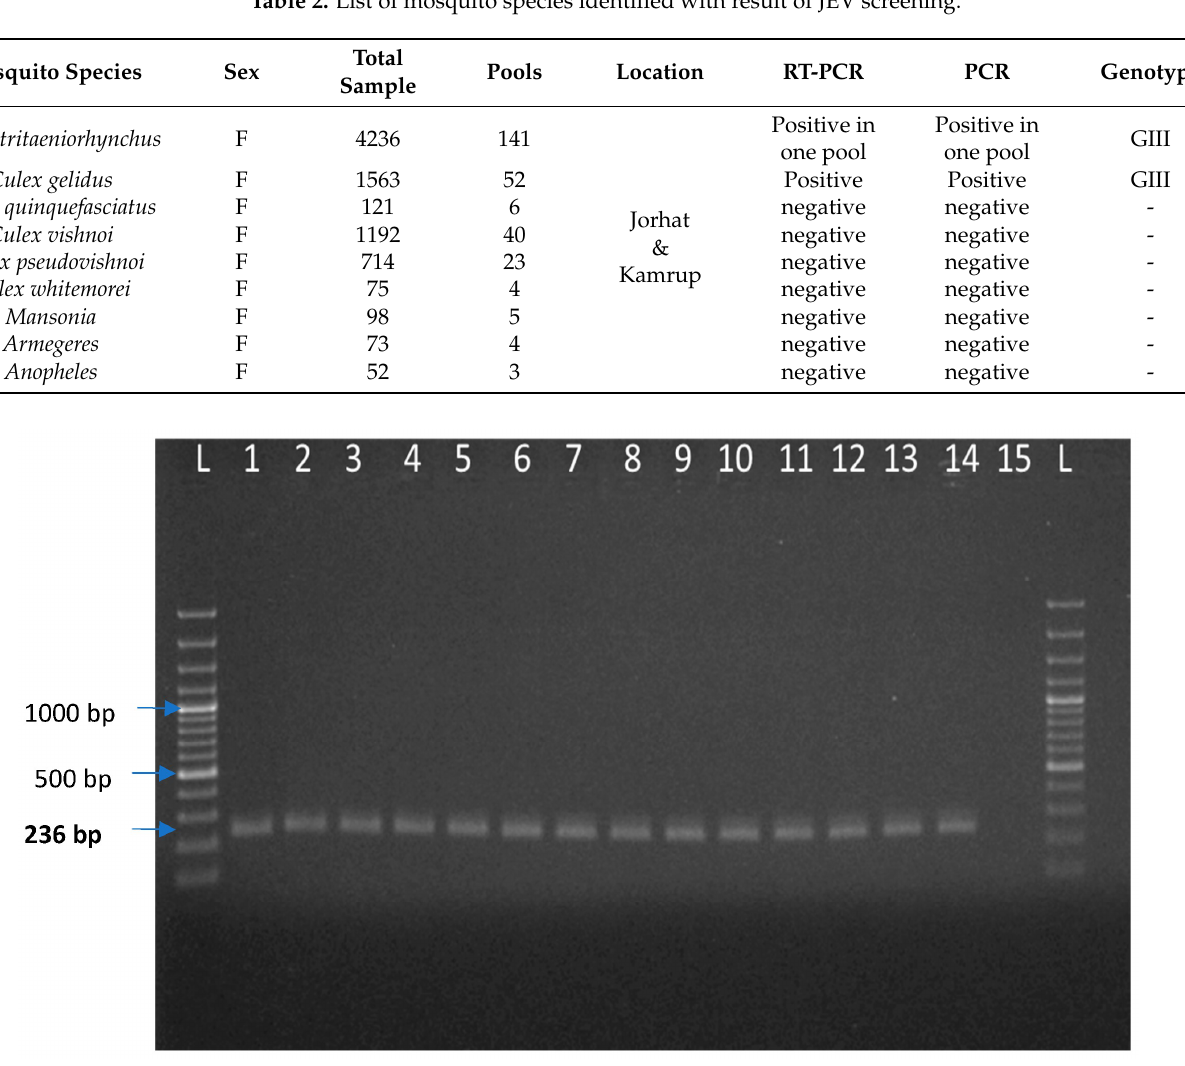
Table 2. List of mosquito species identified with result of JEV screening.